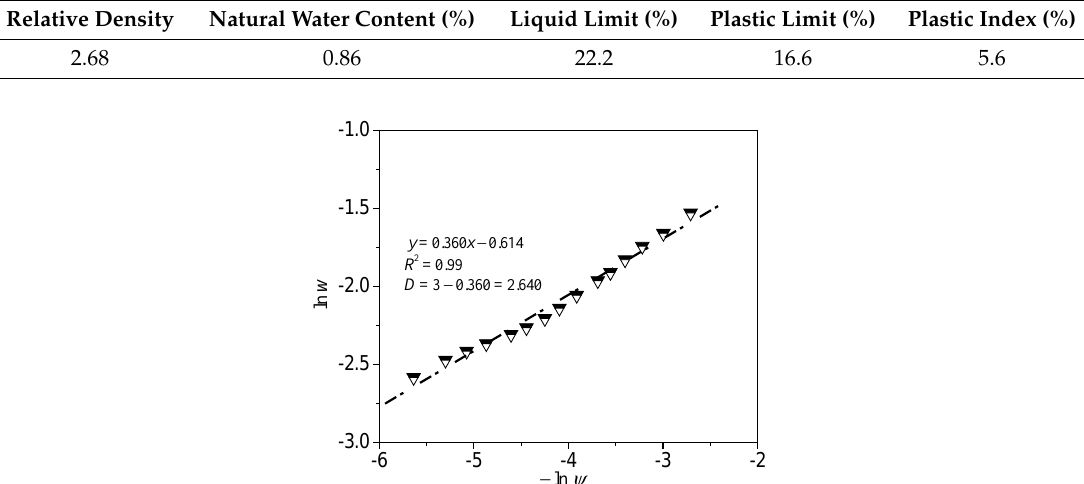
Figure 12. Determination of the values of fractal dimension at reference state through plotting experimental data of ln w against ( − ln ψ ) for Saskatchewan silt (T1) with e 0 = 0.692.